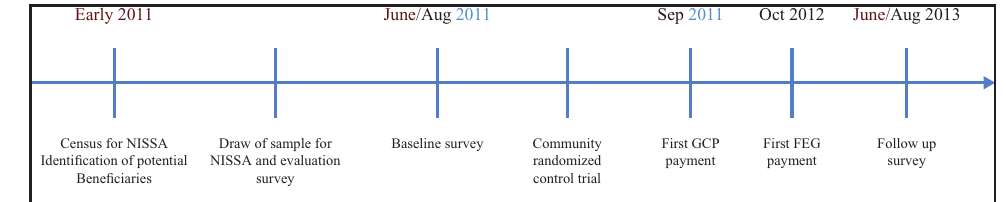
Figure 2 Timeline of Child Grant Programme (CGP) (Phase 1—Round 2)